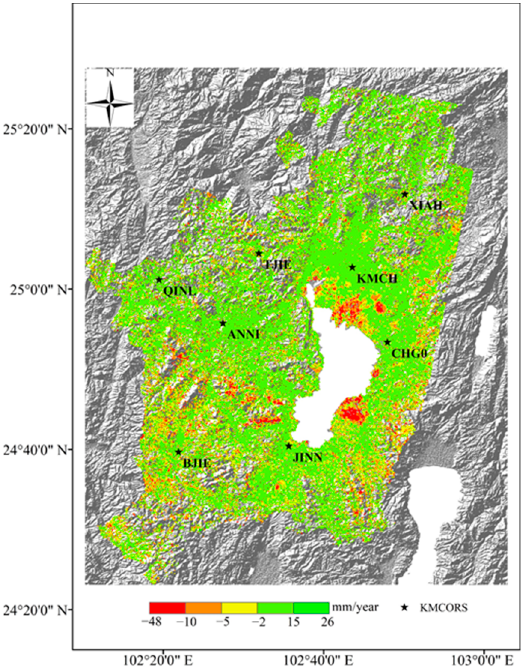
Figure 6. Velocity maps in line of sight (LOS) of the study area.